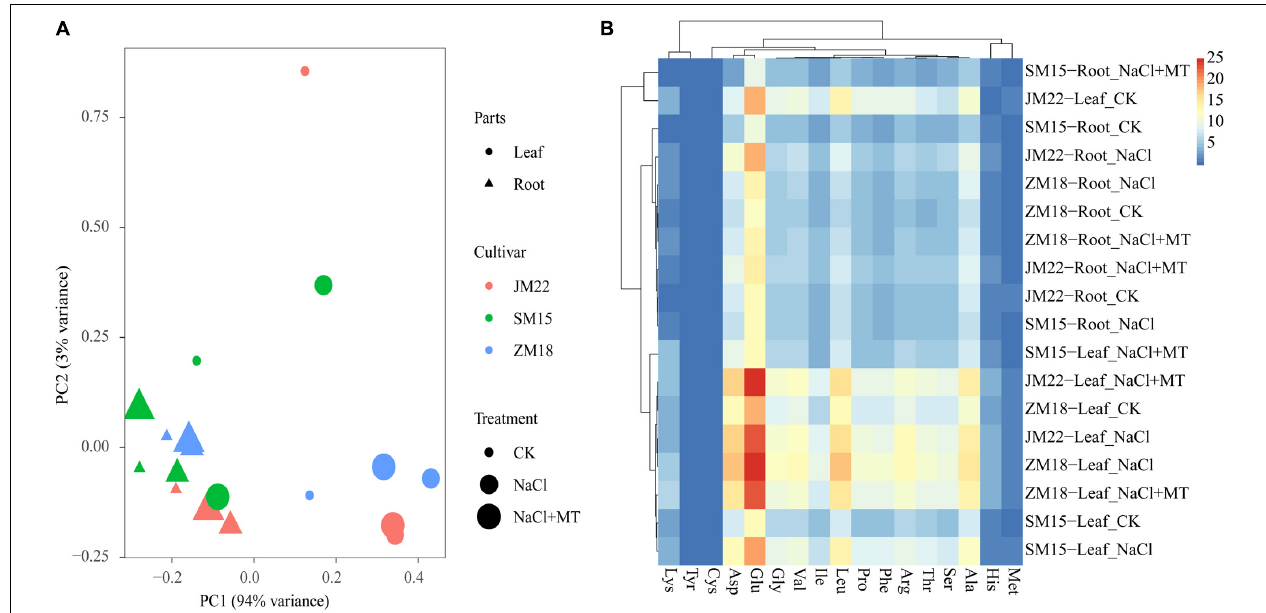
FIGURE 8 | The principal component analysis (PCA) (A) and cluster heatmap (B) of amino acid content of wheat seedlings under different treatments. Asp, aspartic acid; Glu, glutamic; His, histidine; Ser, serine; Arg, arginine; Gly, glycine; Thr, threonine; Pro, proline; Ala, alanine; Val, valine; Met, methionine; Cys, cysteine; Ile, isoleucine; Leu, leucine; Phe, phenylalanine; Lys, lysine; Tyr, tyrosine.